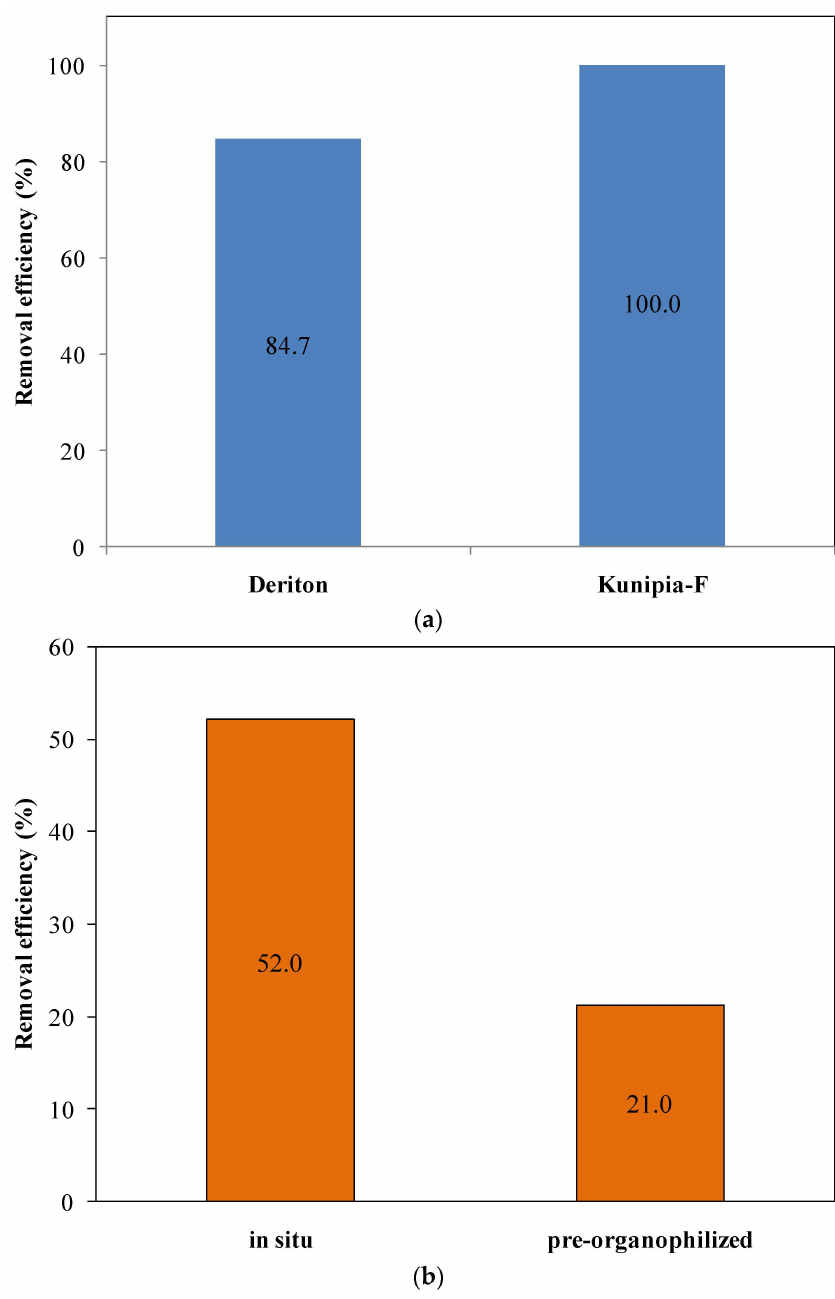
Figure 2. ( a ) Removal of sodium humate (10 mg ¨ L ´ 1 ) by Kunipia-F and Deriton clay minerals; ( b ) removal of phenol (10 mg ¨ L ´ 1 ) by two different adsorption methods ( in situ made and pre-organofilized